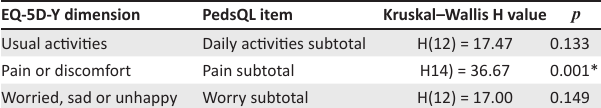
TABLE 1b: Difference in composite scores of the relevant Paediatric Quality of Life scale items across the three different levels of comparable EuroQol five-dimensional youth questionnaire dimensions . n = 64.